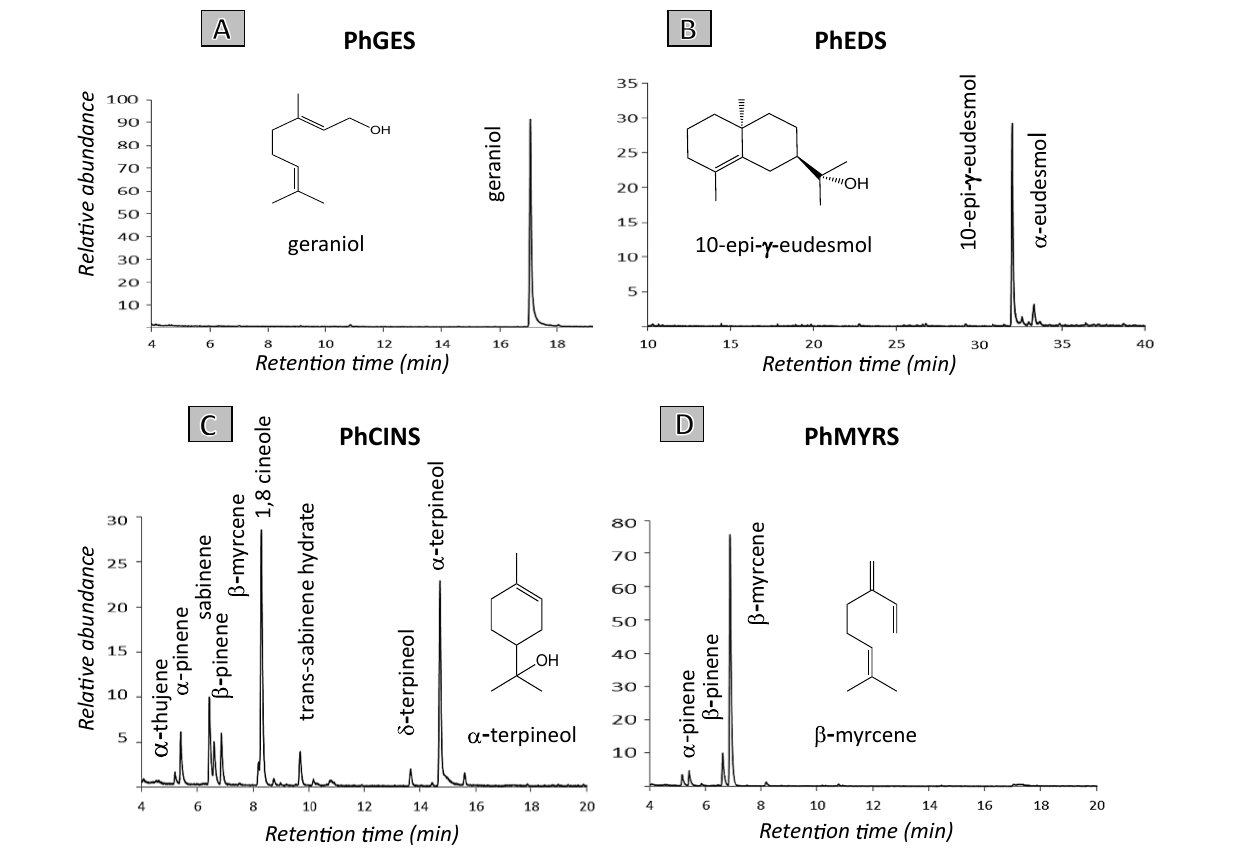
FIGURE 2 | GC-MS analysis of hexane extracts obtained after incubation of PhGES (A) , and PhEDS (B) , respectively, with GPP and FPP. Enzymatic activity of both PhCINS (C) and PhMYRS (D) were characterised after incubation with GPP. Compounds identification was determined by comparison to mass spectra databases (Wiley, NIST, and IFF) and linear retention indices. A comparison of mass spectrum between main products of each enzyme and standards is shown in Supplementary Figure 1 . Enzymatic assays of both PhEDS and PhGES were performed in three independent experiments.